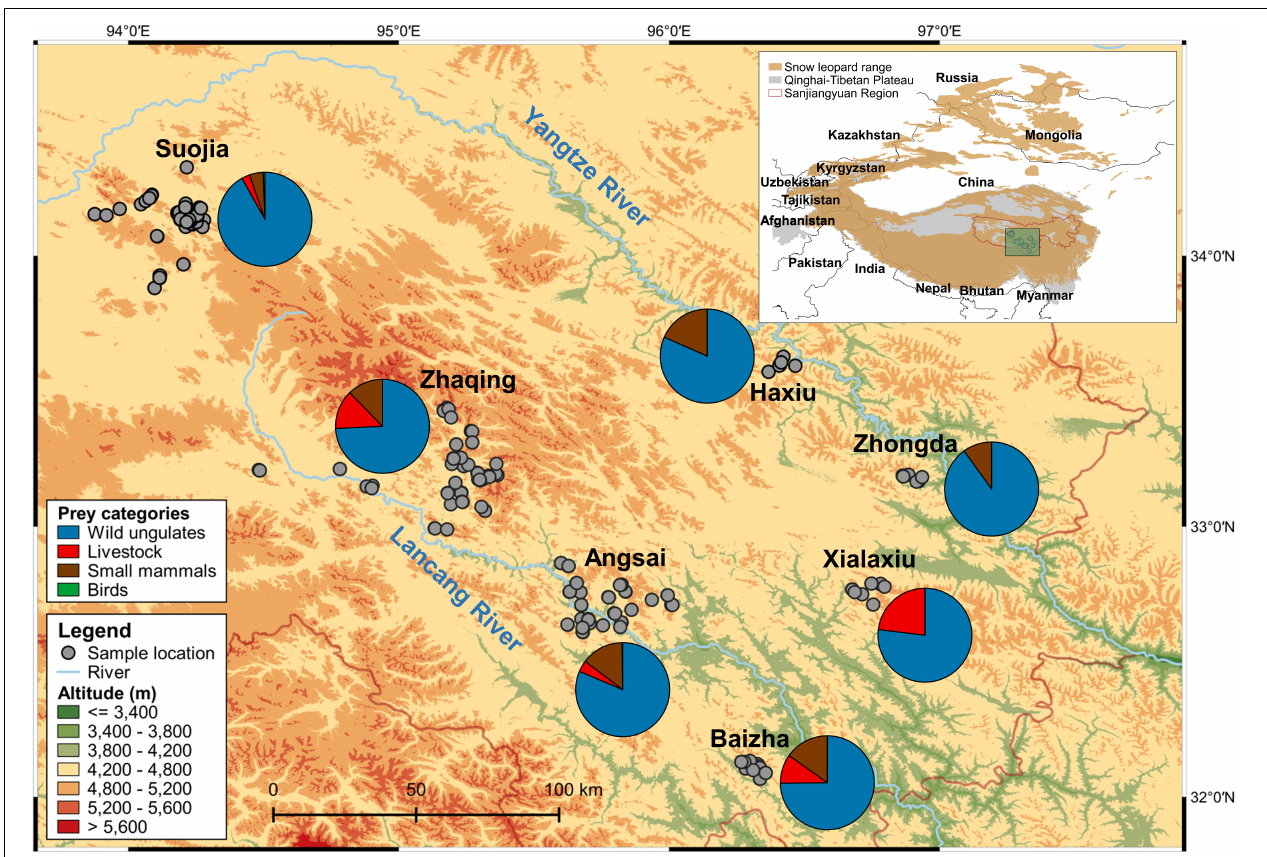
FIGURE 1 | Map of the study region showing sampling locations and snow leopard dietary compositions at each of the seven sites that were analyzed. Pie charts show the relative read abundance of prey categories in the snow leopard diet at each site. The inset shows the locations of the Qinghai-Tibetan Plateau and Sanjiangyuan region, and of the study region (green box) within China. The current global distribution range of the snow leopard was retrieved from the International Union for Conservation of Nature’s Red List of Threatened Species (McCarthy et al.,